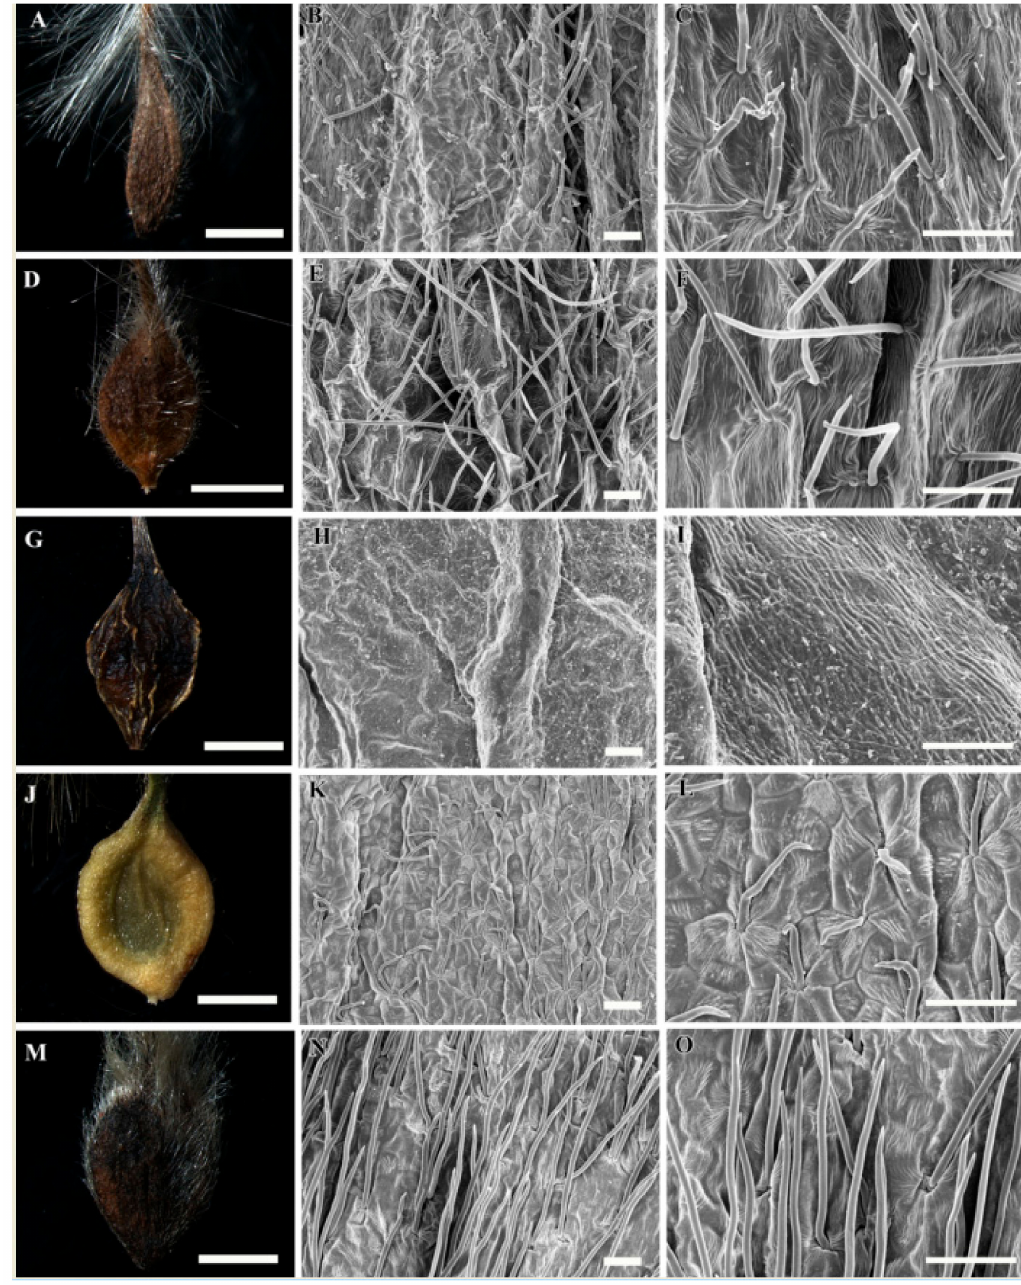
Figure 1. Stereomicroscopic and scanning electron microscopic micrographs of achenes of Clematis . ( A – C ) C. apiifolia . ( D – F ) C. brevicaudata . ( G – I ) C. trichotoma . ( J – L ) C. taeguensis. ( M – O ) C. hexapetala . Scale bars: 2 mm ( A , D , G , J , M ); 100 µ m ( B , C , E , F , H , I , K , L , N , O